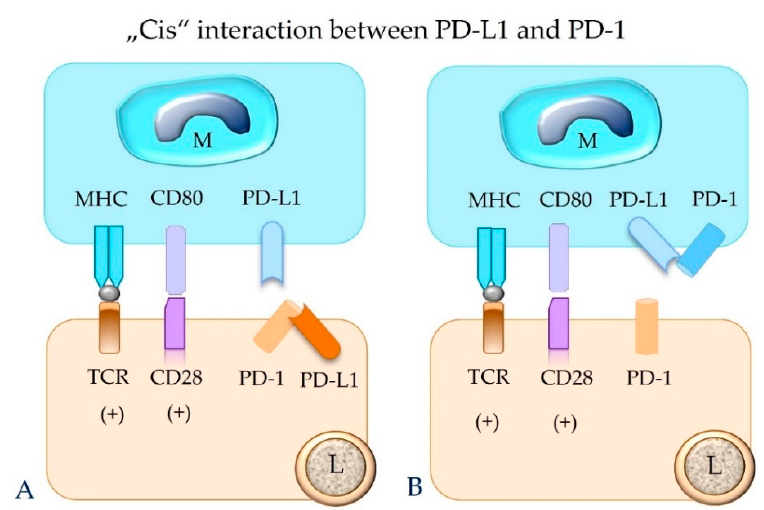
Figure 6. The binding between PD-L1 and PD-1 molecules that are expressed on the same cell (“cis” ligation) will hinder their “trans” interaction. This can result in failure of functional inhibition of the effector T cell. Depicted is “cis” interaction between PD-1 and PD-L1 in a lymphocyte ( A ) and a macrophage ( B ). M = macrophage; L = lymphocyte; TCR = T cell receptor; MHC = major histocompatibility complex class I or II molecule; PD-1 = programmed cell death protein 1; PD-L1 = programmed death-ligand 1.